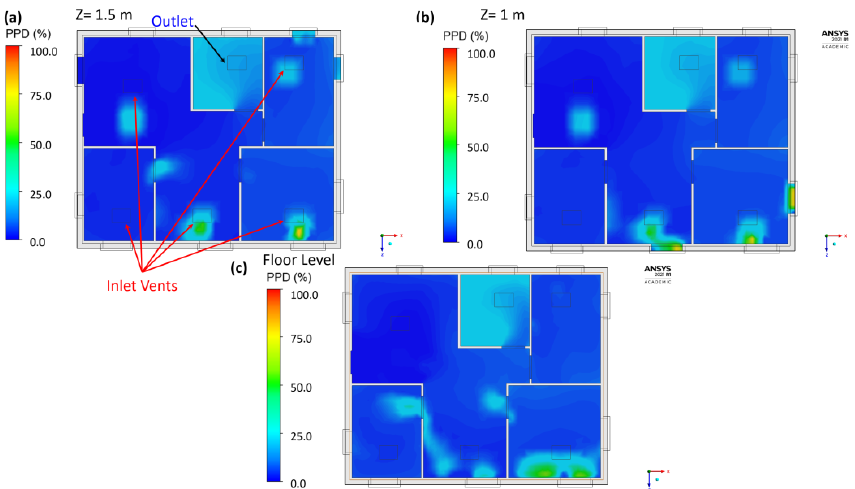
Figure 12. The predicted percentage dissatisfied (PPD) profiles distribution for the house (top view) using Healthy Home standards 2019 inlet temperature 20 °C at different heights ( a ) 1.5 m, ( b ) 1 m, and ( c ) the (finished) floor.